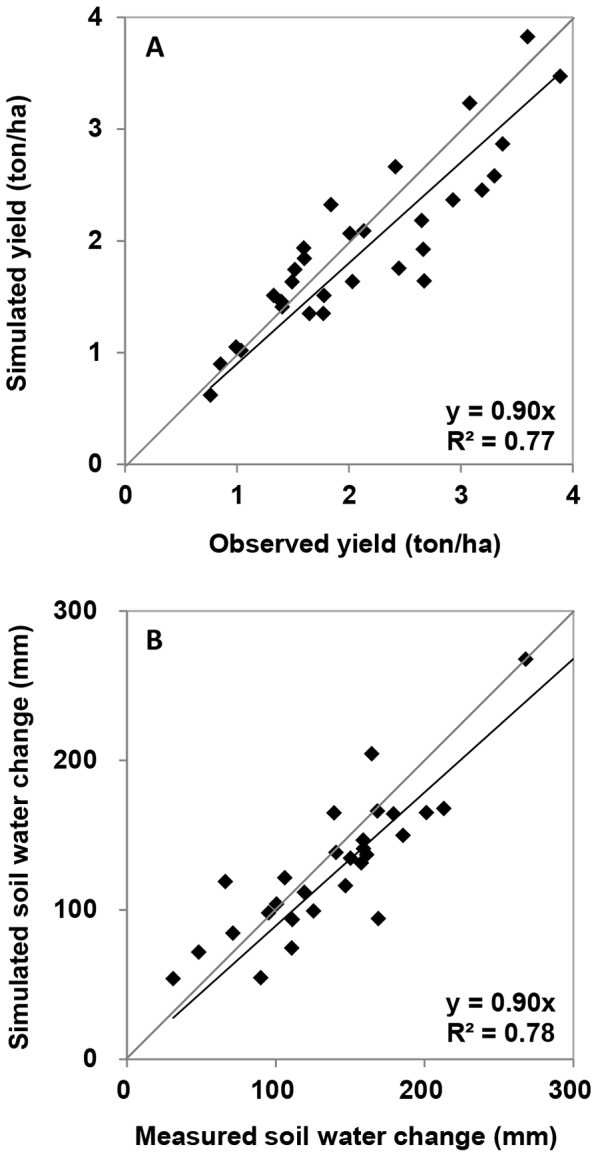
The AquaCrop Model simulations on yield (A) and soil water change (B).Diagonal lines represent 1∶1 lines.